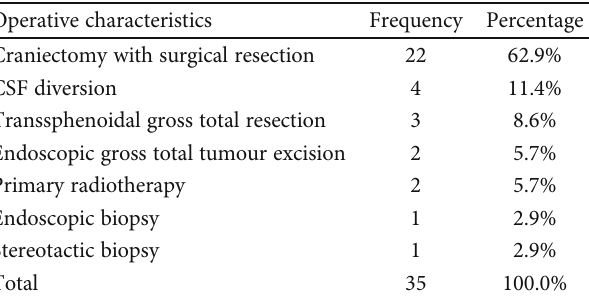
Table 4: Type of surgical intervention.